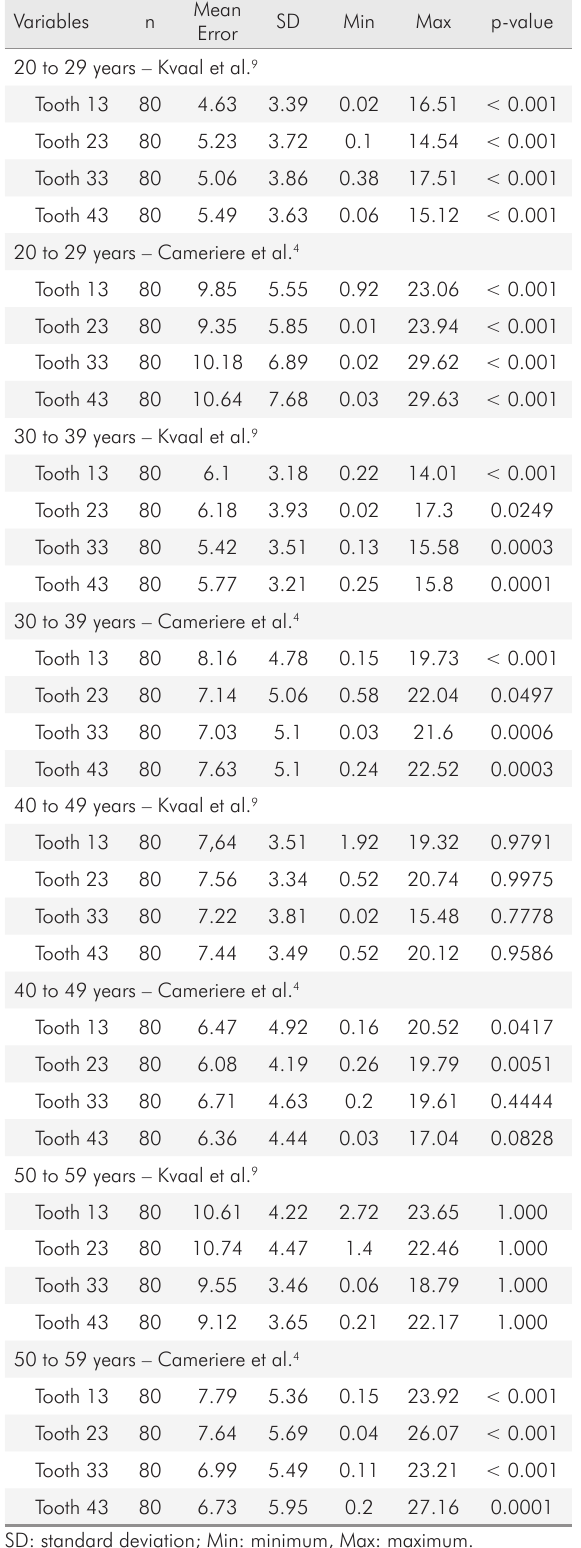
Table 3. Mean error between real age and estimated age by the Kvaal et al. 9 and Cameriere et al. 4 methods by age